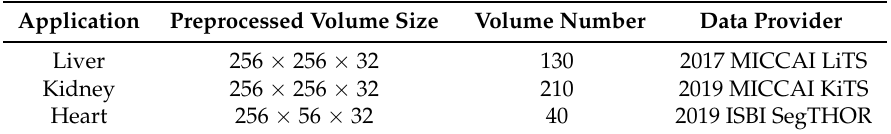
Table 1. An overview of some important information of the medical image datasets used in this